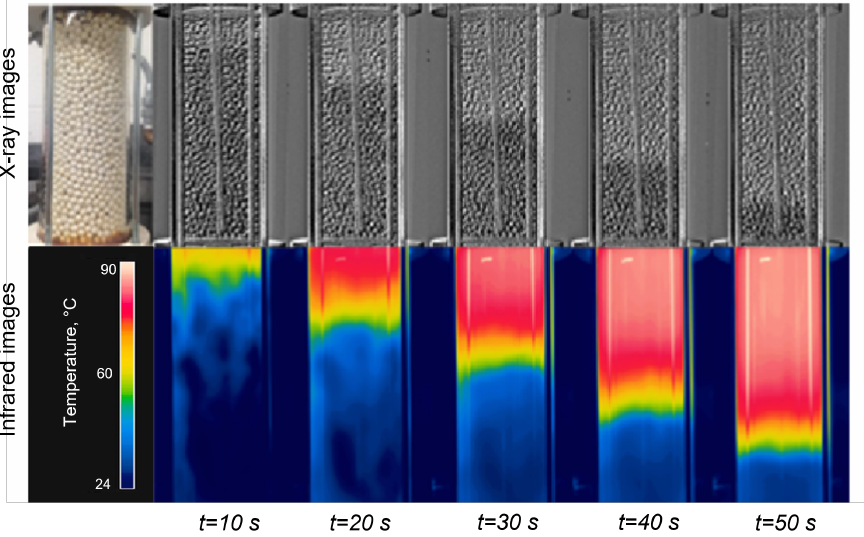
Figure 3. X-ray ( top ) and IR ( bottom ) images of the packed bed storage test section during steam